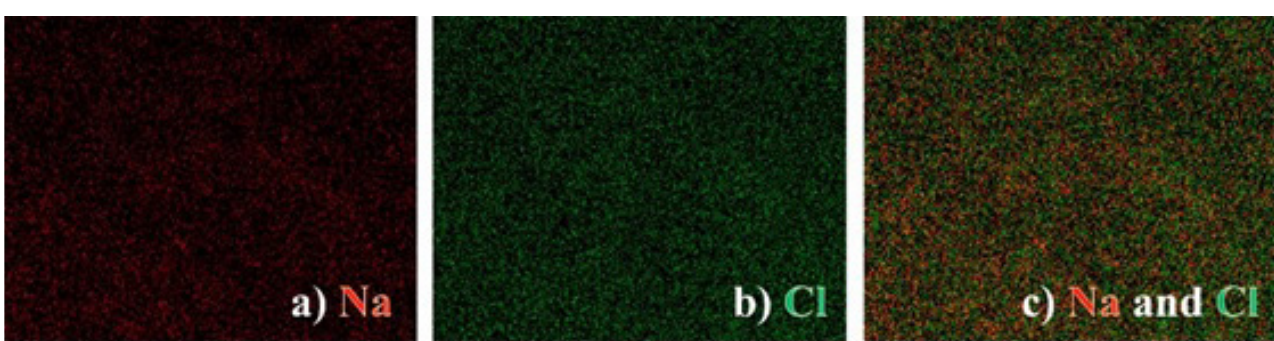
FIGURE 4 - Elemental mapping of NFT/PVA/SA nanofibers (red and green dots represent sodium and chlorine, respectively).